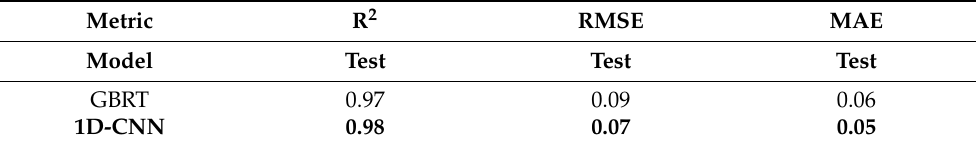
Figure 16. Chart comparing the actual and predicted values of the valve train force by diesel engine RPM using the GBRT and 1D convolutional neural network models. Table 8. A comparison of performance for Base specification data of GRBT and 1D-CNN models (valve seating